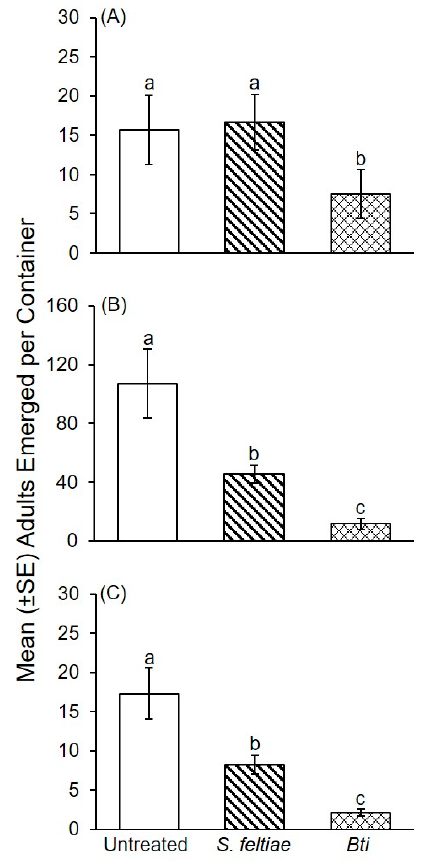
Figure 4. ( A – C ) Mean ( ± SE) number of adult fungus gnats that emerged from straw substrate inoculated with P. ostreatus and treated with either a water control, S. feltiae (Nemashield ® ), or B. thuringiensis var. israelensis (ABG-6193; Gnatrol ® ) during three independent bioassays. Three independent bioassays were conducted over time and presented as A-C. Means within a bioassay with different letters are significantly different (one-way ANOVA; Fisher’s LSD test; α = 0.05). In the second bioassay with P. ostreatus , significantly fewer fungus gnats emerged from straw treated with Bti compared to S. feltiae and the water control (Figure 4B: F 2, 27 = 14.35; p < 0.0001). Significantly fewer adults also emerged from straw treated with S. feltiae compared to the water control. The Bti treatment resulted in an 89% reduction compared to the water control versus 57% for S. feltiae